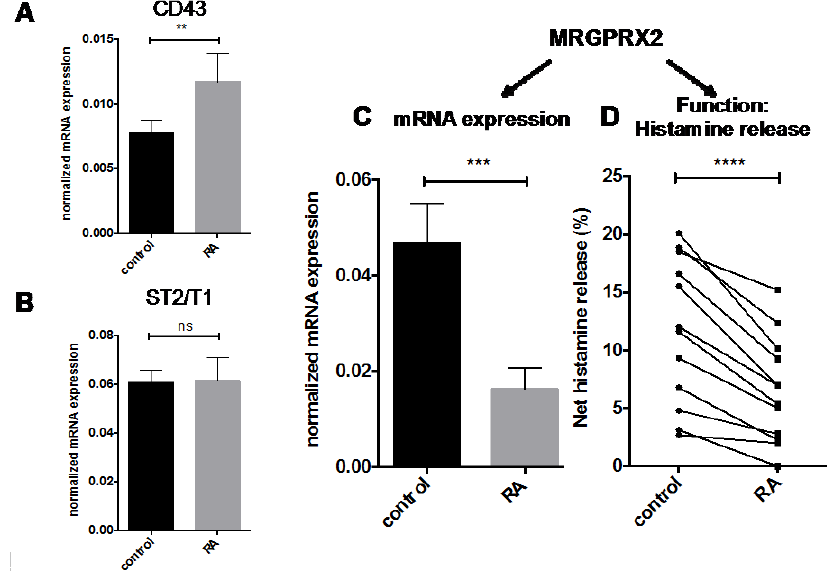
Figure 4. Impact of RA on other genes and MC-restricted processes. Relative mRNA expression, normalized to β actin , for ( A ) the pan-hematopoietic sialoprotein CD43 (the latter used as control of an RA-upregulated gene); ( B ) the IL-33 receptor ST2/T1, and ( C ) the MC-selective receptor MRGPRX2, Mean ± SEM, n = 9; ( D ) net histamine release elicited by MRGPRX2 triggering (by use of its agonist compound 48/80 at 10 μg/mL) in RA pretreated and control MCs (analogous to Figure 3C,D). n = 12. Each dot corresponds to one MC preparation and dots representing the same donor are connected. ** p < 0.01, *** p < 0.001, **** p < 0.0001 significantly different from control (by paired t -test); ns = not significant.